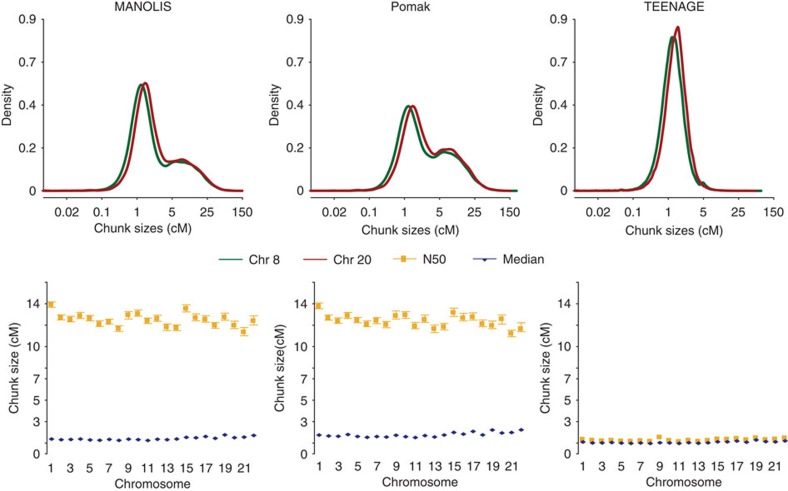
Maximal haplotype sharing between nearest-neighbours (NNs) for each cohort.The output of our algorithm is a set of shared haplotypes of different lengths. The top panel shows the density curves for the shared haplotype chunks for chromosomes 8 (dark green) and 20 (dark red). Results were similar for the other chromosomes. The bottom panel shows the per chromosome median (dark blue) and N50 (gold), in cM, of all shared haplotype chunks obtained from all the unrelated individuals (pi hat<0.2, see Methods) in each cohort. The 95% confidence intervals (CIs), obtained by bootstrapping using 1000 repeats of resampling without replacement, are denoted by the horizontal bars (where these are very tight they are not visible in the plot). The median chunk length tells us about the distribution of contigs; however, we may also be interested in what a randomly sampled location will look like. The N50 measures this; specifically, it is a chunk length such that 50% of all randomly chosen positions will fall in a chunk of at least that size.